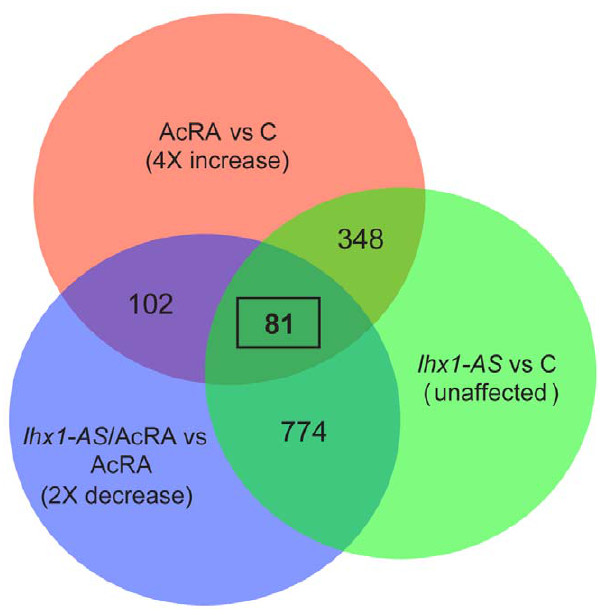
Figure 5. Microarray analysis of lhx1 -depletion in organ culture. Venn diagram outlining the distribution of probe sets in the three organ culture treatments. Overlap between probe sets that showed a 4-fold or greater increase in expression in AcRA treated (AcRA) vs untreated (C) explants (pink), probe sets that presented a 2- fold or greater decrease in expression on lhx1-AS /AcRA vs AcRA explants (blue) and probe sets which expression showed less than a 0.5- fold increase/decrease in injected ( lhx1-AS ) vs C explants were considered unaffected (green).